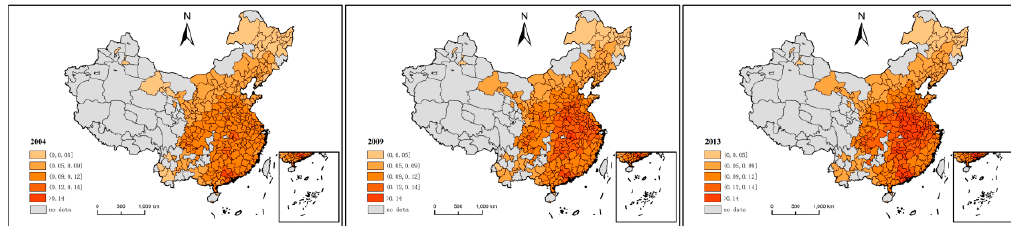
Figure 4. Spatiotemporal distribution of borrowing economic activity density.